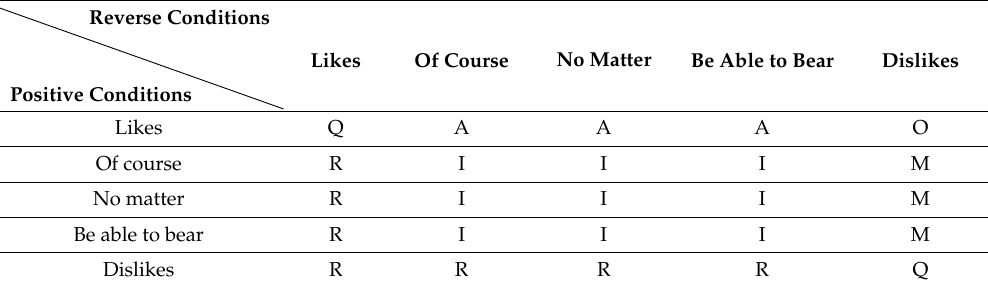
Table 2. Decision Matrix of Qualitative